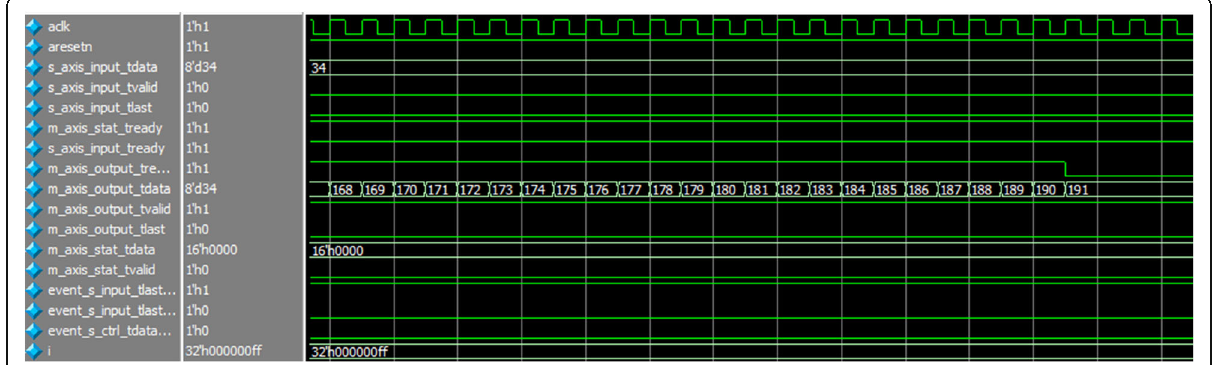
Fig. 13 The simulation diagram 3 of the RS decoder. The output data of the decoders. The output data of RS decoding is the input of RS encoding. And the RS encoding is